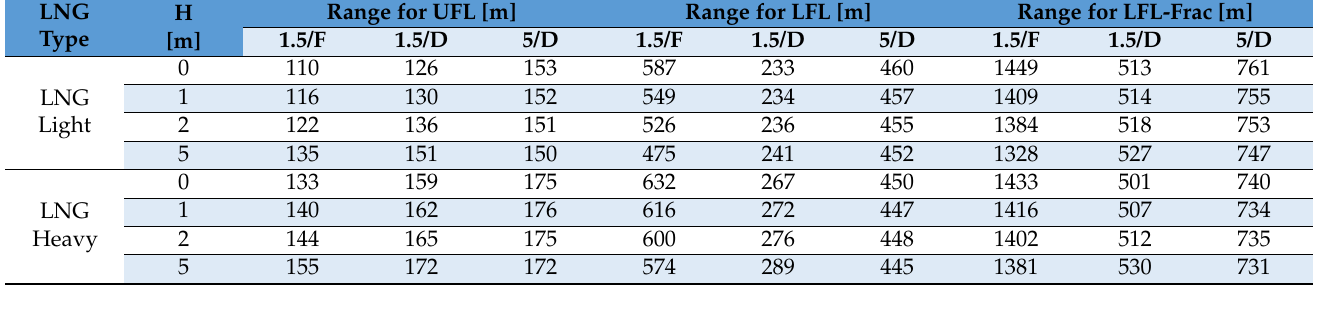
Table 4. Dispersion, catastrophic rupture, summer.